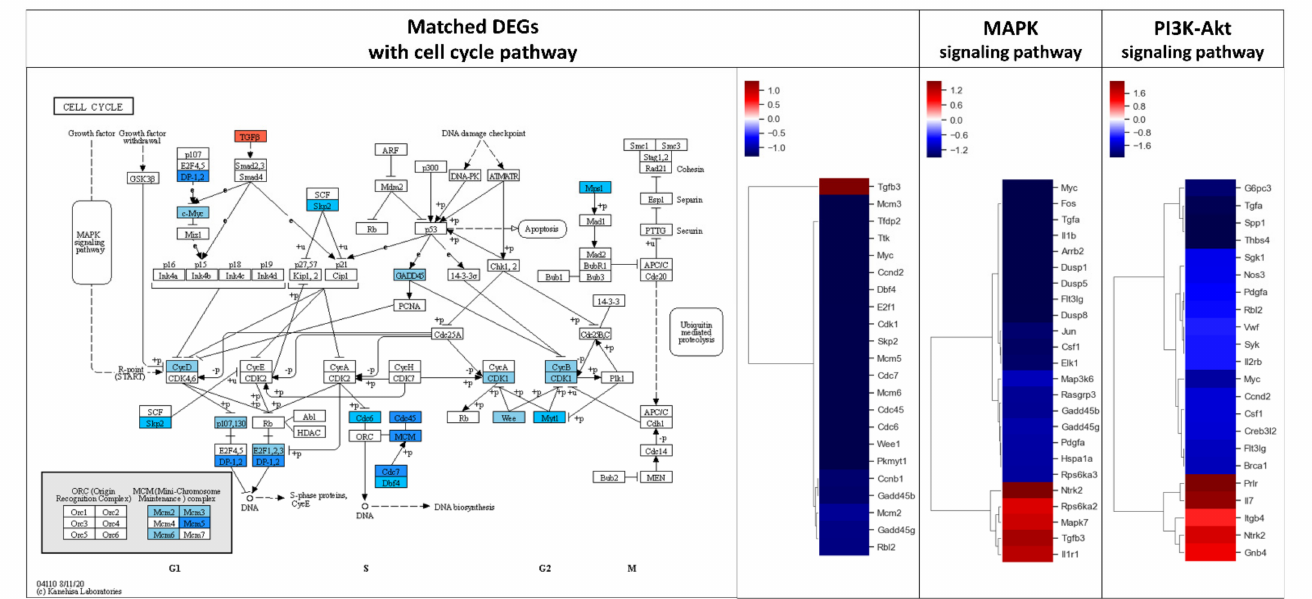
Figure 3. Results of KEGG pathway mapping. 2-fold changed DEGs were analyzed using the KEGG pathway database. 24, 22, and 22 DEGs were included in cell cycle, MAPK signaling, and PI3K-Akt signaling pathways, respectively. AS-IV showed down-regulatory effects on these pathways. Only a few DEGs were up-regulated in these three pathways. MAPK signaling and PI3K-Akt signaling pathways were upstream of the cell cycle pathway. The red and blue color in the figure indicate up-regulation and down-regulation of genes, respectively. Intensity of color is proportional to fold